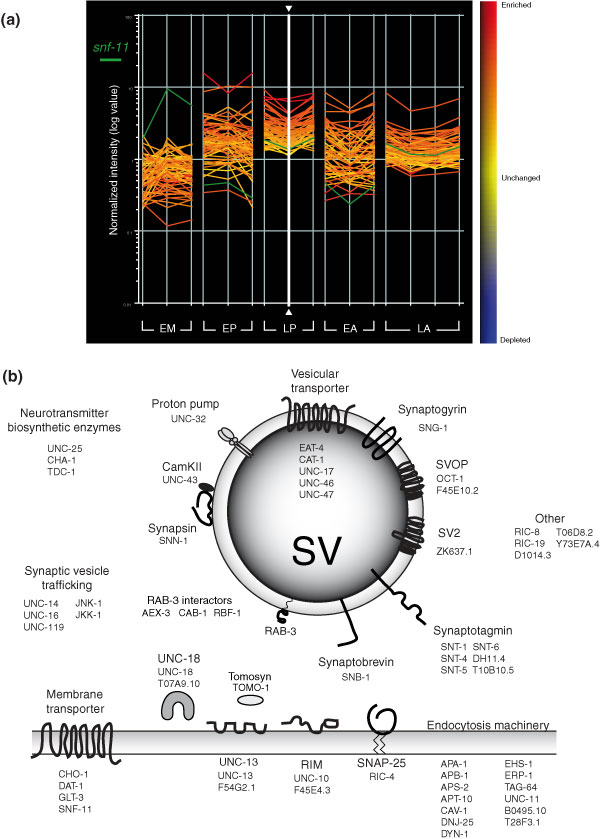
Transcripts encoding proteins that function in synaptic transmission are enriched in the neural datasets but largely excluded from muscle. (a) The line graph depicts 61 synaptic transmission genes that are enriched in the larval pan-neural (LP) dataset (colors from heat map at right are defined by LP sample denoted by vertical white line with arrowheads). Most of these transcripts are also enriched in other neuronal datasets (embryonic pan-neural (EP), embryonic A-class motor neuron (EA), larval A-class motor neuron (LA)) but not in embryonic muscle (EM). An exception is snf-11 (horizontal green line), the membrane-bound GABA transporter, which is significantly elevated in the EM and LP datasets, consistent with its known expression in muscle and neurons [26]. (b) Many of the proteins encoded by the 61 LP-enriched synaptic transmission genes are localized to synaptic vesicles (SV; center circle) or to the plasma membrane (shaded rectangle). Other proteins are predicted to perform related functions, such as the synthesis of neurotransmitters and/or vesicular trafficking.